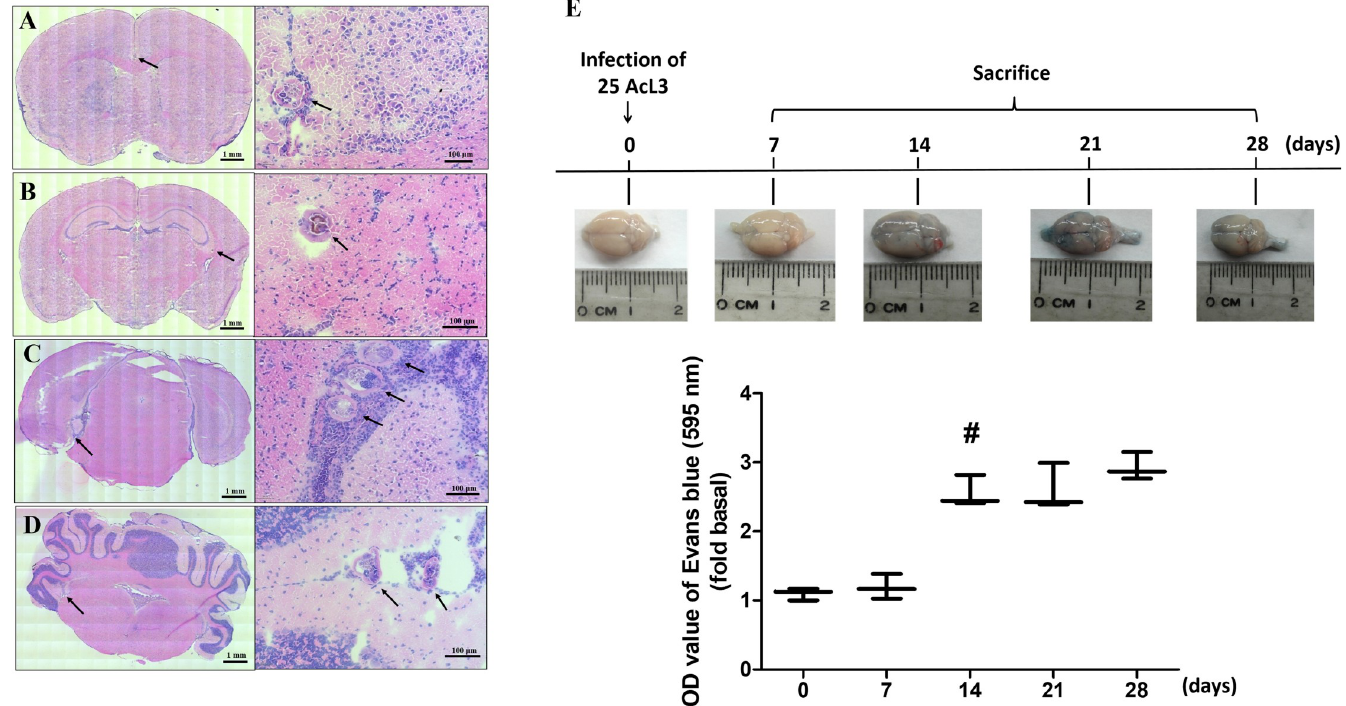
Fig 1. Histopathological changes and blood-brain barrier dysfunction are induced in Angiostrongylus cantonensis- infected mice. Fifth-stage larvae of A . cantonensis were observed in the (A) anterior cerebral fissure, (B) hippocampus, (C) posterior cerebral fissure, and (D) cerebellar fissure of mice infected with 25 third- stage larvae on day 14 postinfection (stained with hematoxylin-eosin). Inflammatory cells were found surrounding these larvae. (E) Blood-brain barrier dysfunction and breakdown was shown by positive staining after the intravenous infusion of 2% Evans blue into the brains of mice infected with Angiostrongylus cantonensis on days 0, 7, 14, 21 and 28 postinfection.